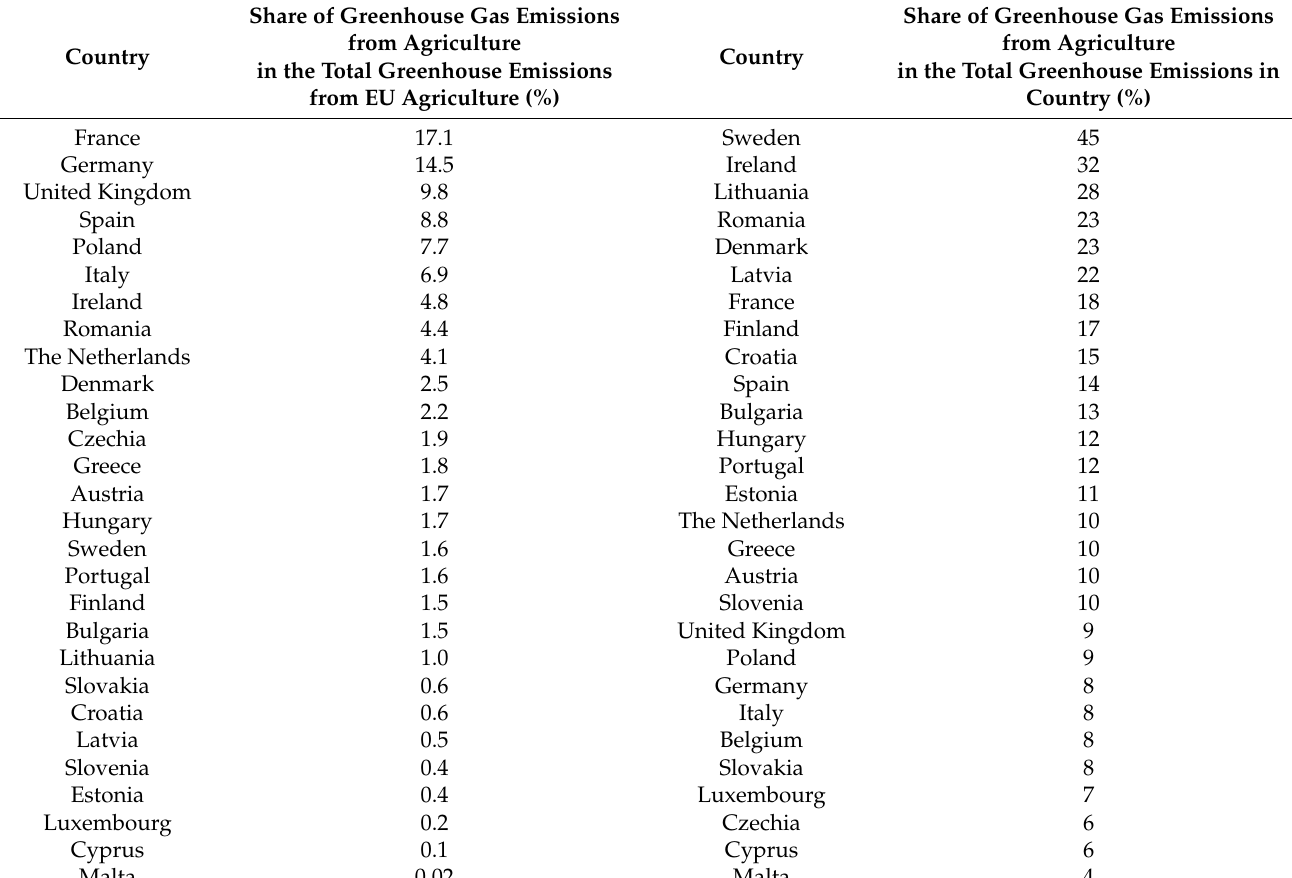
Table 1. Share of GHG from agriculture * of a given country in the total GHG from EU agriculture and in the total GHG in a given country, 2019 (%).